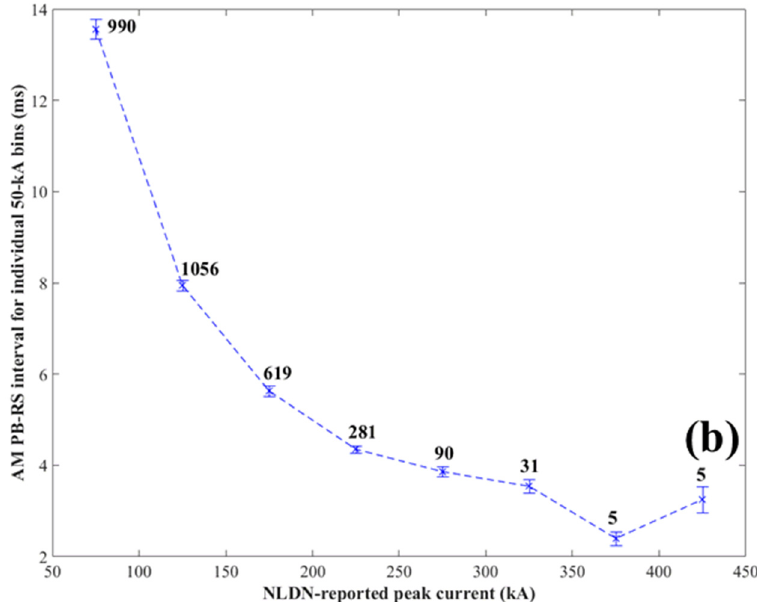
Figure 9. ( a ) Scatterplot of PB-RS interval versus NLDN-reported RS peak current for 3077 negative first strokes within 50 to 500 km of LOG. The best-fit curve, y = 1560 × x − 1.12 − 0.694, is shown by solid line. R is the Spearman correlation coefficient; ( b ) AM values of PB-RS interval for individual 50-kA bins versus NLDN-reported RS peak current. The standard errors in mean values are shown by vertical bars and the corresponding sample sizes are given above them.